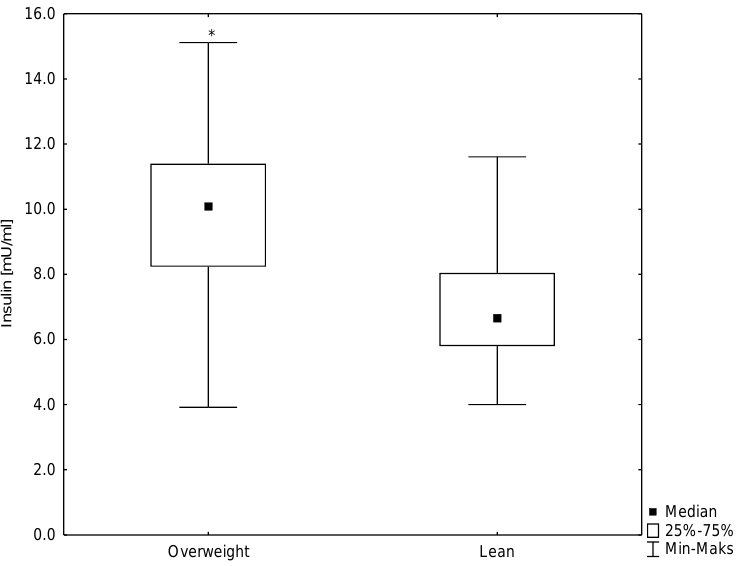
Figure 2. A box-whisker plot for the insulin concentrations in the studied groups. * statistically significant difference at p < 0.05